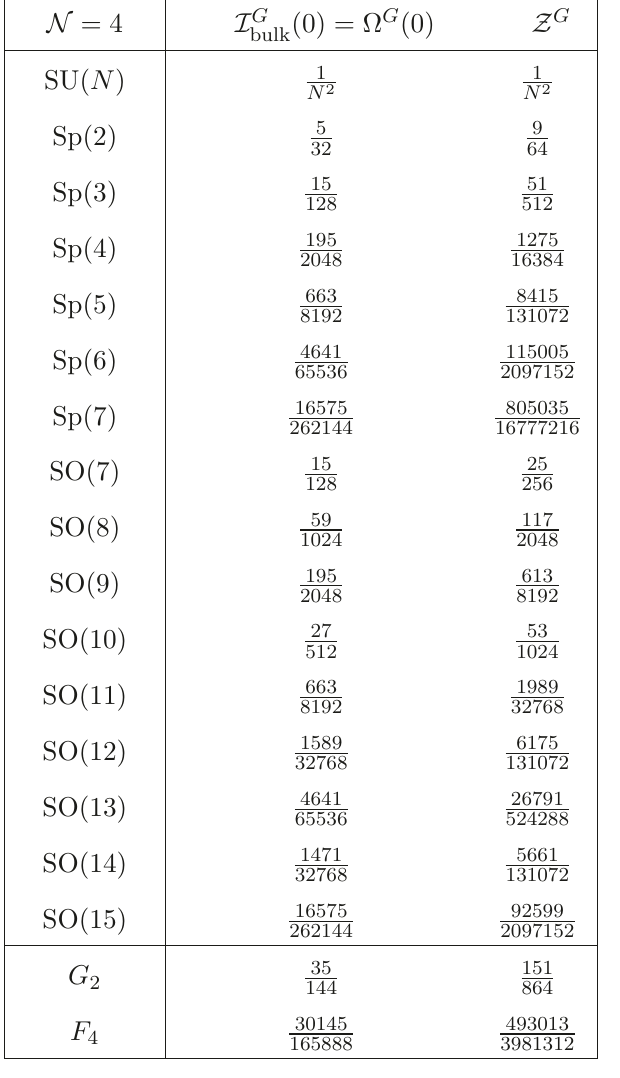
G Table 1 . bulk vs. Z I SO(6) SU(4) ≃